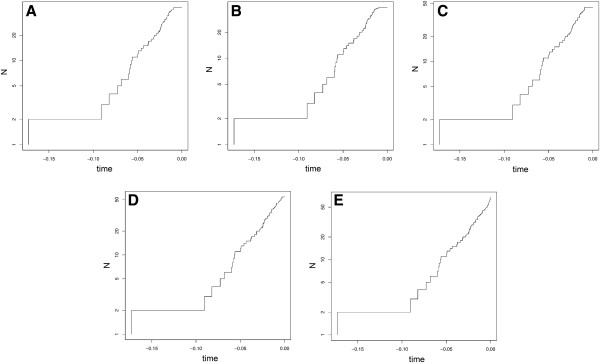
Lineage through time plots (LTT-plot). The diversification of lineages (y-axis; cumulative number of lineages) through time (x-axis; relative time estimates) is plotted in five different ways according to the delimitation of evolutionary lineages: A: 3.2% threshold value partition. B: Automatic Barcoding Gap Detection (ABGD) partition. C: Statistical Parsimony (SP) partition. D: General Mixed Yule-Coalescent single (GMYCs) partition. E: General Mixed Yule-Coalescent multiple (GMYCm) partition.